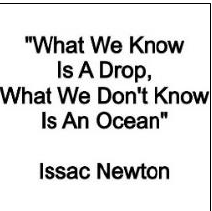
Figure 7. Message.jpeg.